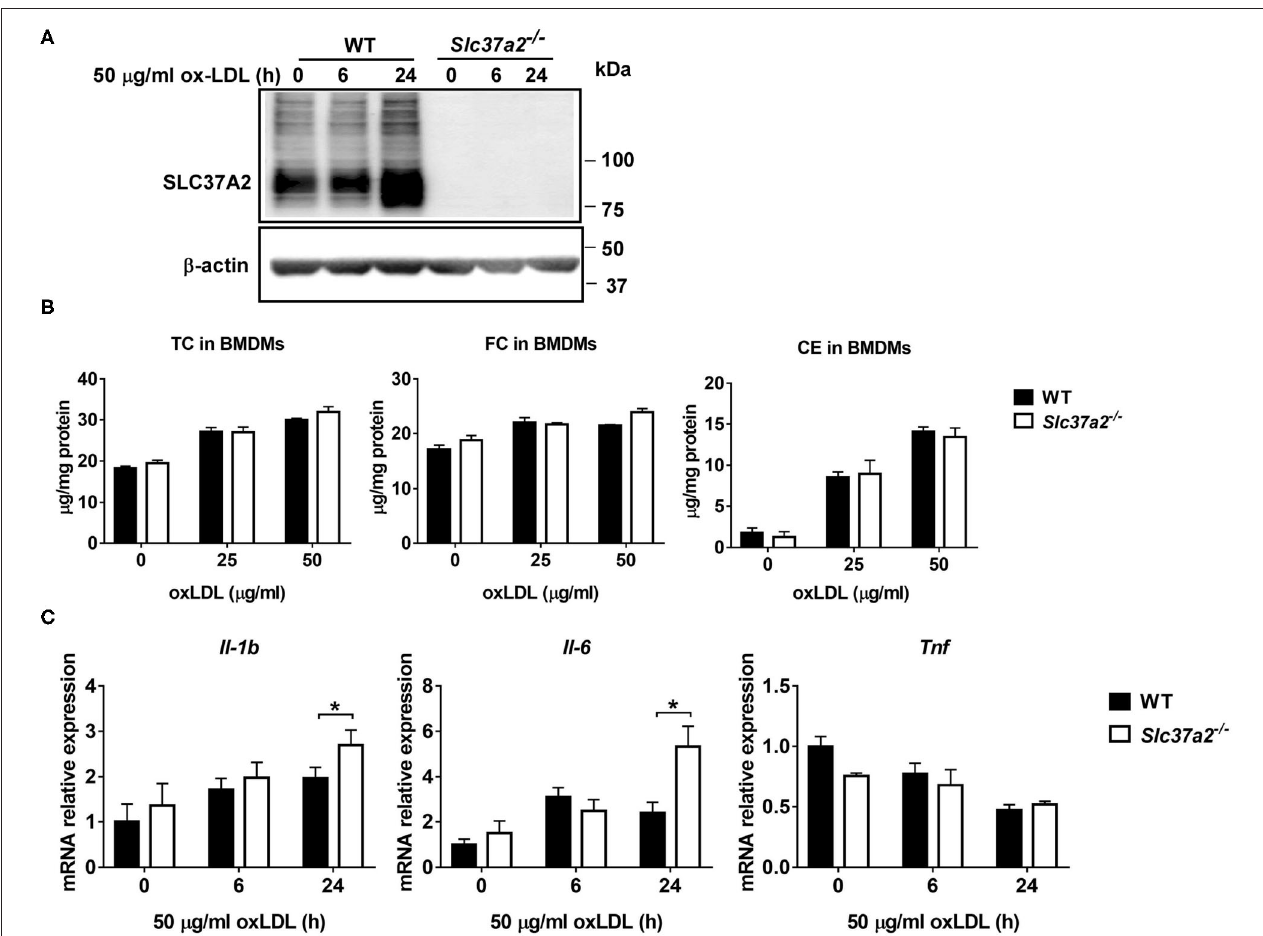
FIGURE 5 | SLC37A2 deficiency promotes oxidized LDL (OxLDL)-induced macrophage inflammation in vitro . (A) SLC37A2 protein expression analyzed by Western blotting in WT and Slc37a2 − / − bone marrow-derived macrophages (BMDMs) treated with 50 µ g/ml oxLDL for 0-24h. (B) Quantification of cellar total cholesterol (TC), free cholesterol (FC), and cholesterol ester (CE) in WT and Slc37a2 − / − BMDMs after treated with or without 25 or 50 µ g/ml oxLDL for 24h. (C) Relative transcript level of cytokines in WT and Slc37a2 − / − BMDMs stimulated with 50 µ g/ml oxLDL for 0-24h, measured by qPCR. Data are representative of two independent experiments with three samples per group (mean ± SEM). * p < 0.05; unpaired, two-tailed Student’s t -test.